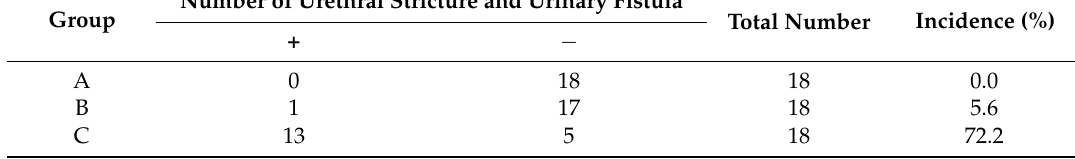
Table 1. The incidences of post-operation complications including urethral stricture and urinary fistula in rabbits.